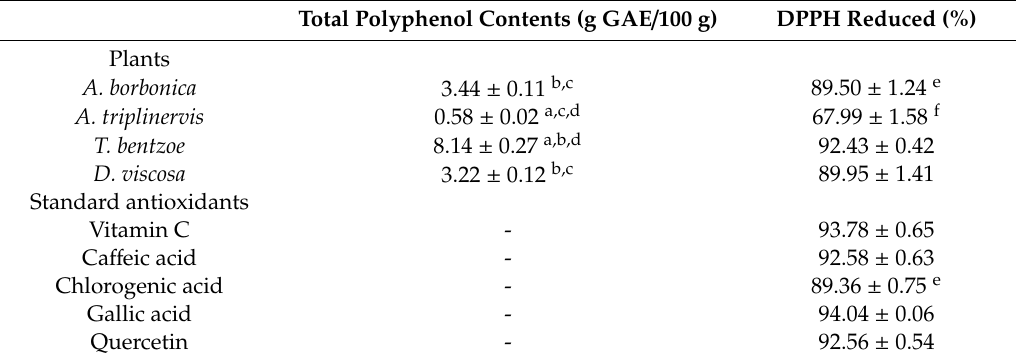
Table 3. Total polyphenol contents and free radical-scavenging and reducing activities of plant extracts.